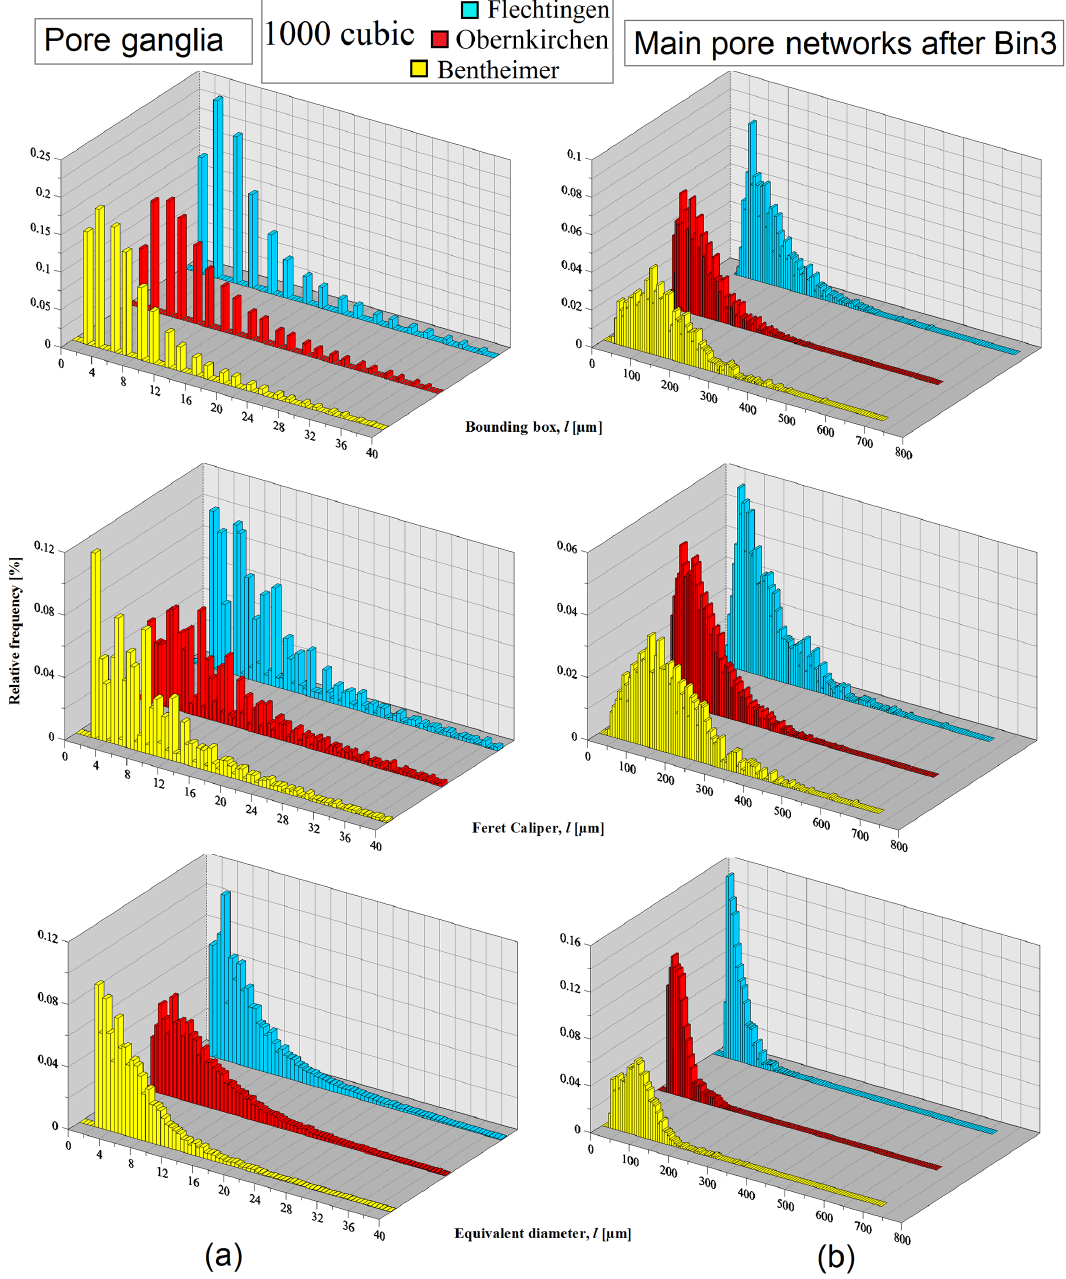
Figure 6. Pore thickness ( l ) distribution of pore ganglia (a) and detached pore networks after Bin3 (b) as measured by the BB, FC, and EqD methods in the 1000 3 voxel volume of S 1 (yellow), S 2 (red), and S 3